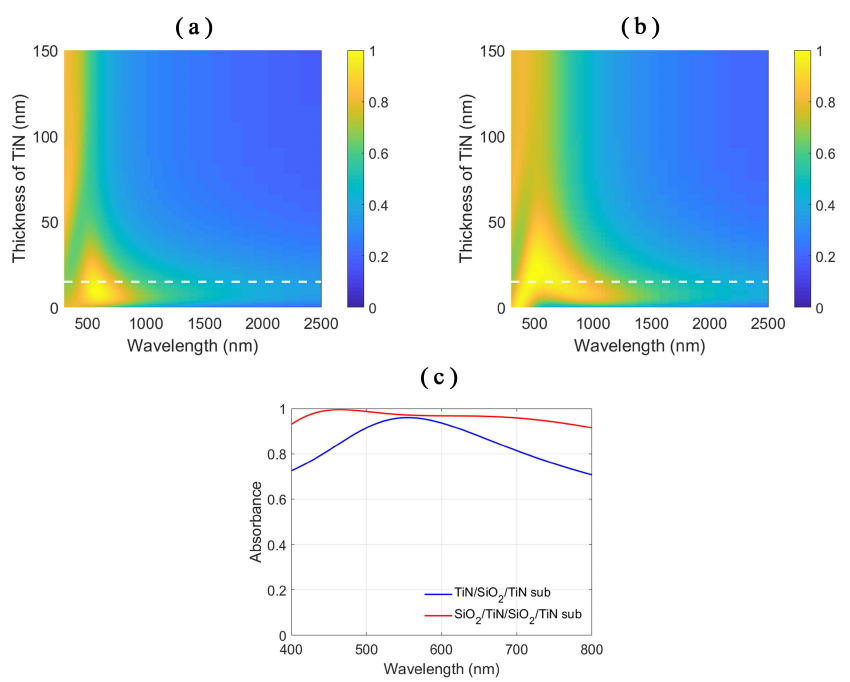
Figure 3. Absorption spectra of: ( a ) the TiN/SiO 2 /TiN stacks; and ( b ) the SiO 2 /TiN/SiO 2 /TiN stacks with respect to the varying thickness of the TiN layer. The thickness of the SiO 2 layer is 85 nm. Color bar denotes the absorbance value of the stacks. ( c ) The absorbance plots of the stacks with size parameters chosen as the thickness of TiN layer on the top 15 nm, the thickness of the SiO 2 layer 85